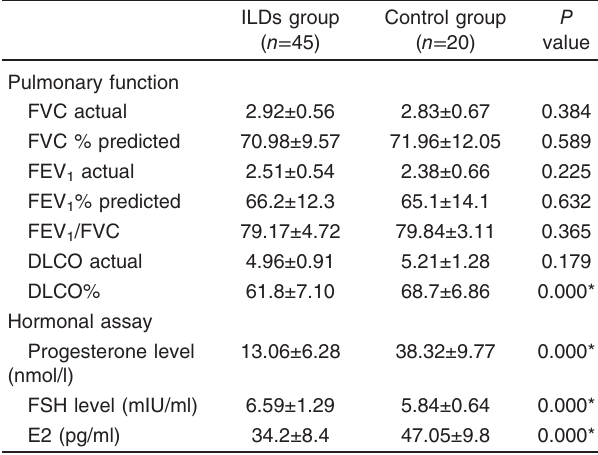
Table 5 Correlation of the global female sexual function index score with sociodemographic variables, pulmonary